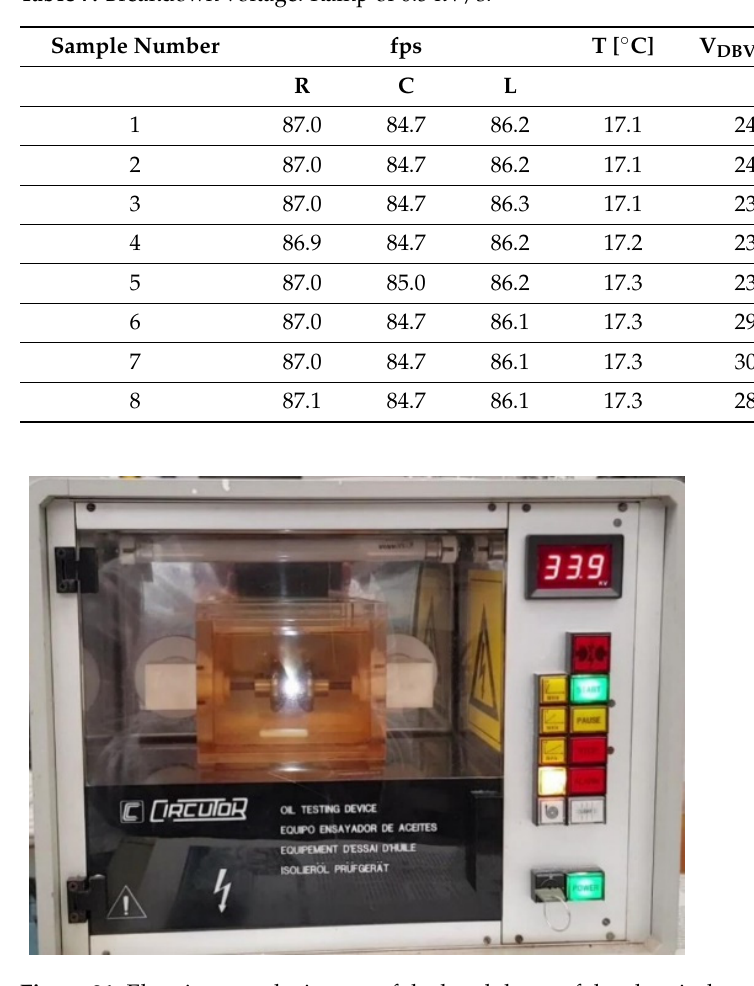
Figure 21. Electric arc at the instant of the breakdown of the electrical strength, with a value of the dielectric breakdown voltage of 33.9 kV. Here, fps is frames per second and R, C and L refer to the right, central and left cameras, respectively. In Figure 4, R, C and L correspond to A, B and C,